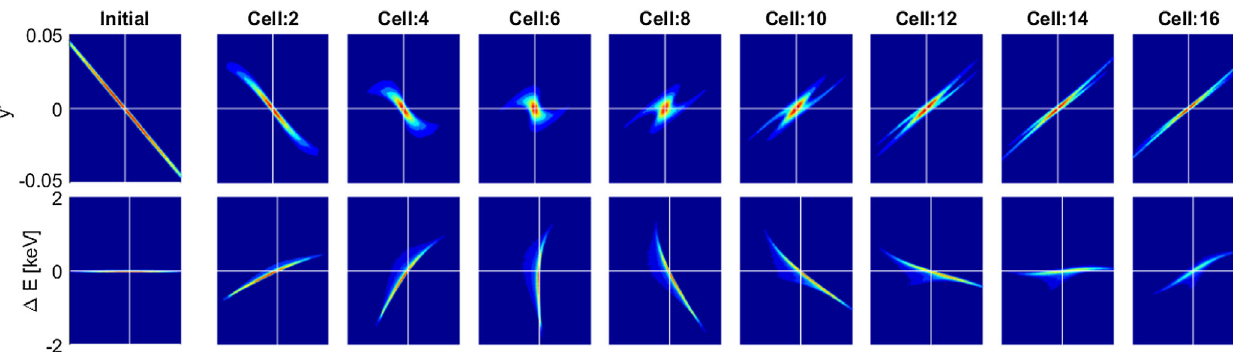
FIG. 15. Longitudinal (bottom) and transverse (top) phase space for 16 cells of the chirped grating with the beam initially focused into the structure. The axes are − 100 nm < y < 100 nm and 1 . 5 < φ < 2 . 6 . Again, the color represents the phase space density, normalized to the maximum of the second column.